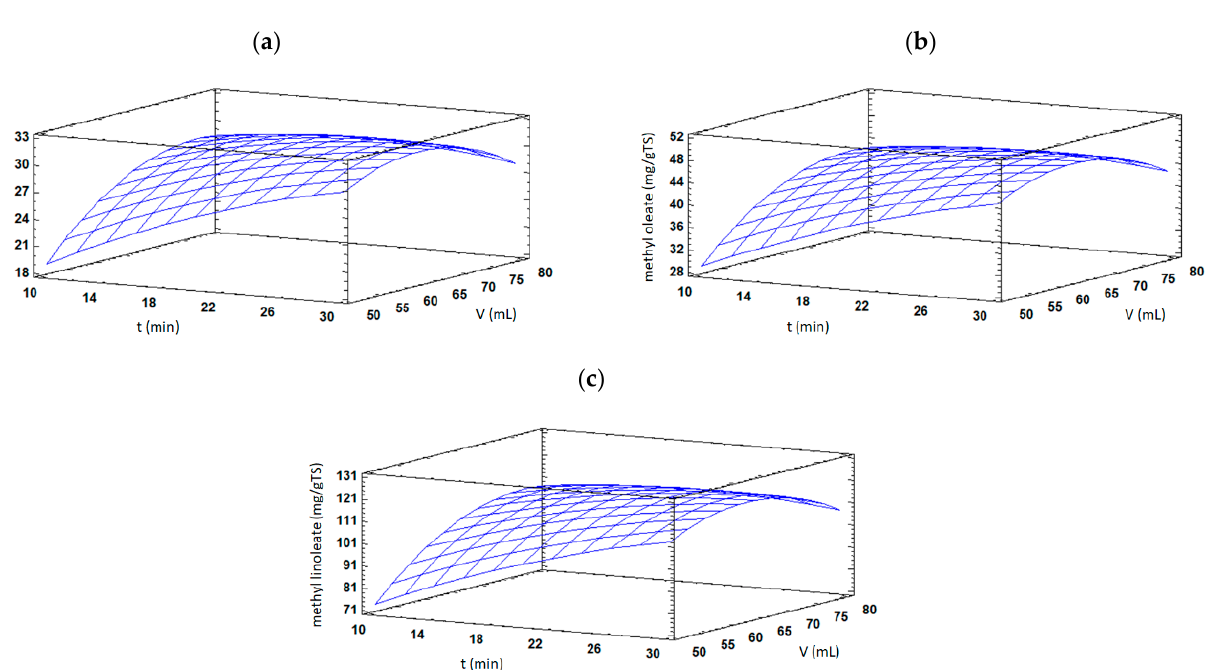
Figure 3. Response surface plots of significant interactions between extraction time vs. solvent volume on ( a ) methyl palmitate, ( b ) methyl oleate, and ( c ) methyl linoleate contents in TSO by MAE. In all cases, extraction temperature was fixed at its central value.